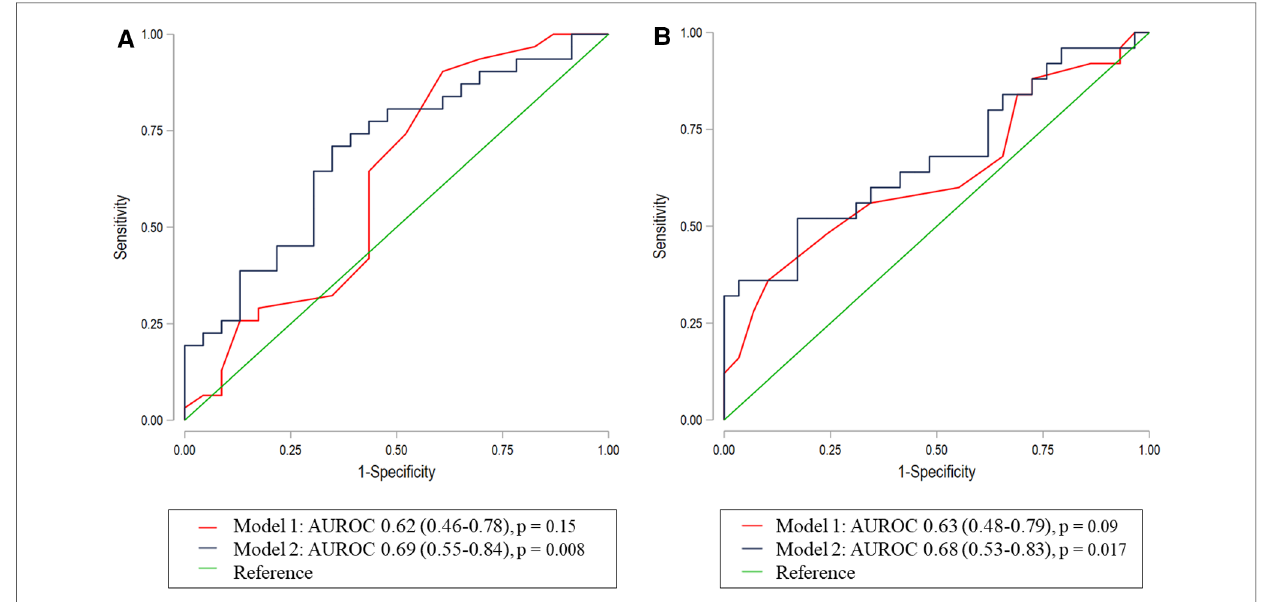
FIGURE 3 Receiver operating characteristic curves to predict hospital mortality and weaning Off ECMO. The receiver operative characteristic curves using Model 1 (SAVE score) (red), and Model 2 (SAVE score and echocardiographic parameters of left ventricular systolic function obtained at 100% ECMO target blood fl ow) (blue) to predict ( A ) hospital mortality and ( B ) successful weaning from V-A ECMO. Model 2 had the best discriminative ability with an area under the receiver operating characteristic curves of 0.69 (95% CI 0.55 – 0.84), p =0.008 and 0.68 (95% CI 0.53 – 0.83), p =0.017, respectively. * p -value compares to neutrality AUROC, Area under the receiver operating characteristic; V-A ECMO, veno-arterial extracorporeal membrane oxygenation.